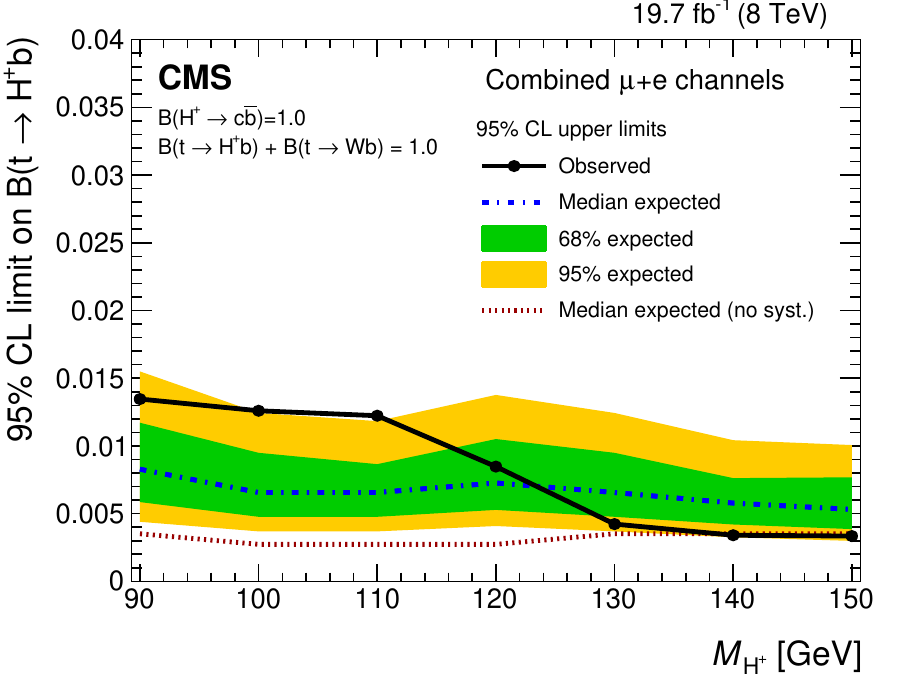
Figure 3 . Upper limits at the 95% con(cid:12)dence level (CL) on the branching fraction B (t ! H + b), assuming B (H + ! cb) = 1 : 0 and B (t ! H + b) + B (t ! Wb) = 1 : 0, for the combined (cid:22) +jets and e+jets channels. The black solid line shows the observed limit. The mean expected limit is shown as a blue dashed line and the green/yellow bands indicate the 68/95% con(cid:12)dence intervals for the expected limits. The red dotted line shows the mean expected limit in the absence of systematic